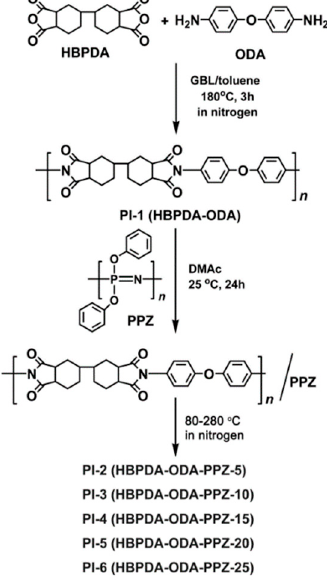
Figure 1. Preparation of PI-1 (HBPDA-ODA) and PI / PPZ composite films (PI-2~PI-6).